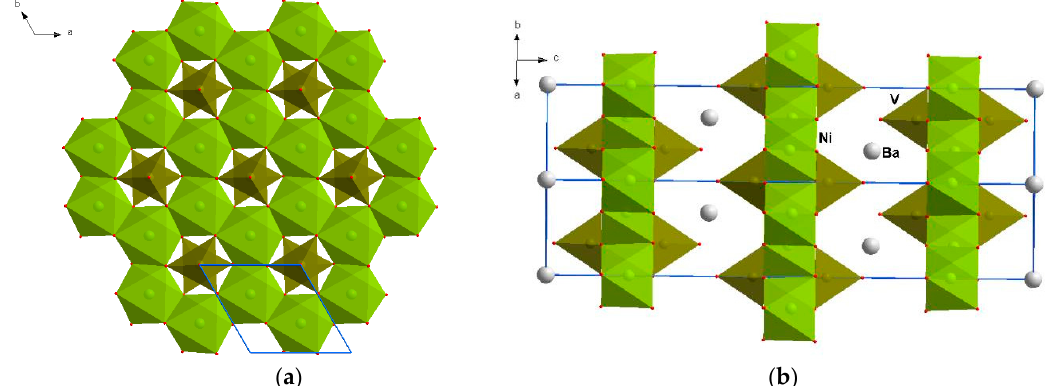
Figure 6. The {Ni 2 [VO 4 ] 2 } 2- module based on a gibbsite-type layer in the crystal structure of BaNi 2 [VO 4 ] 2 ( a ) and its alternation with Ba-cations in [110] projection ( b ).